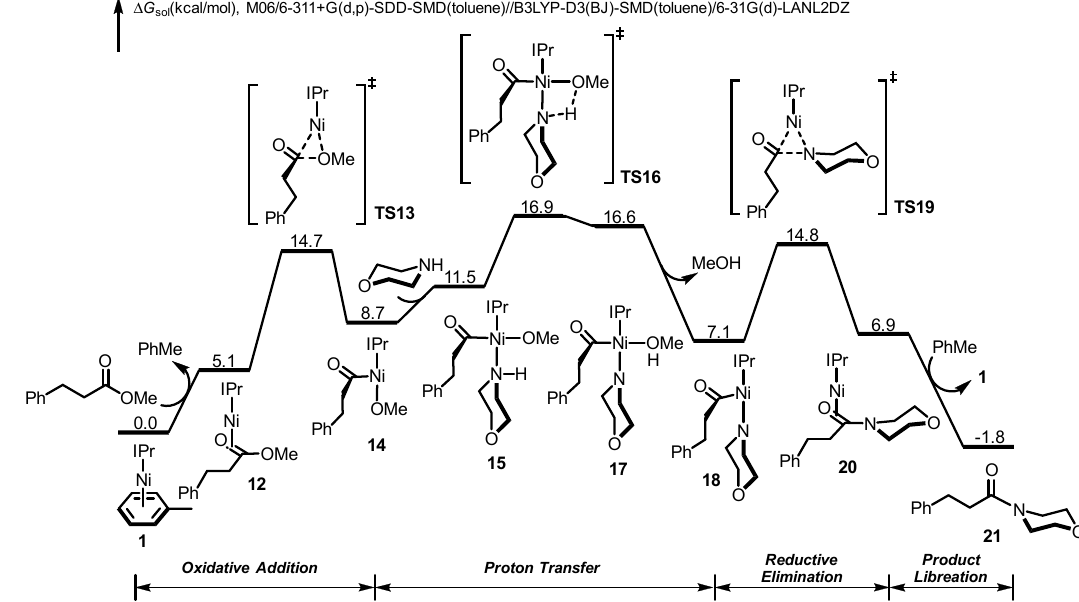
Figure 3. Density functional theory (DFT)-computed free energy profile of Ni/IPr-catalyzed amidation of aliphatic ester.